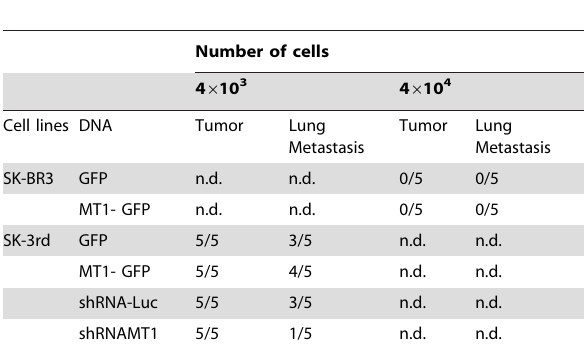
Table 1. In Vivo Tumorigenicity and Spontaneous Metastasis